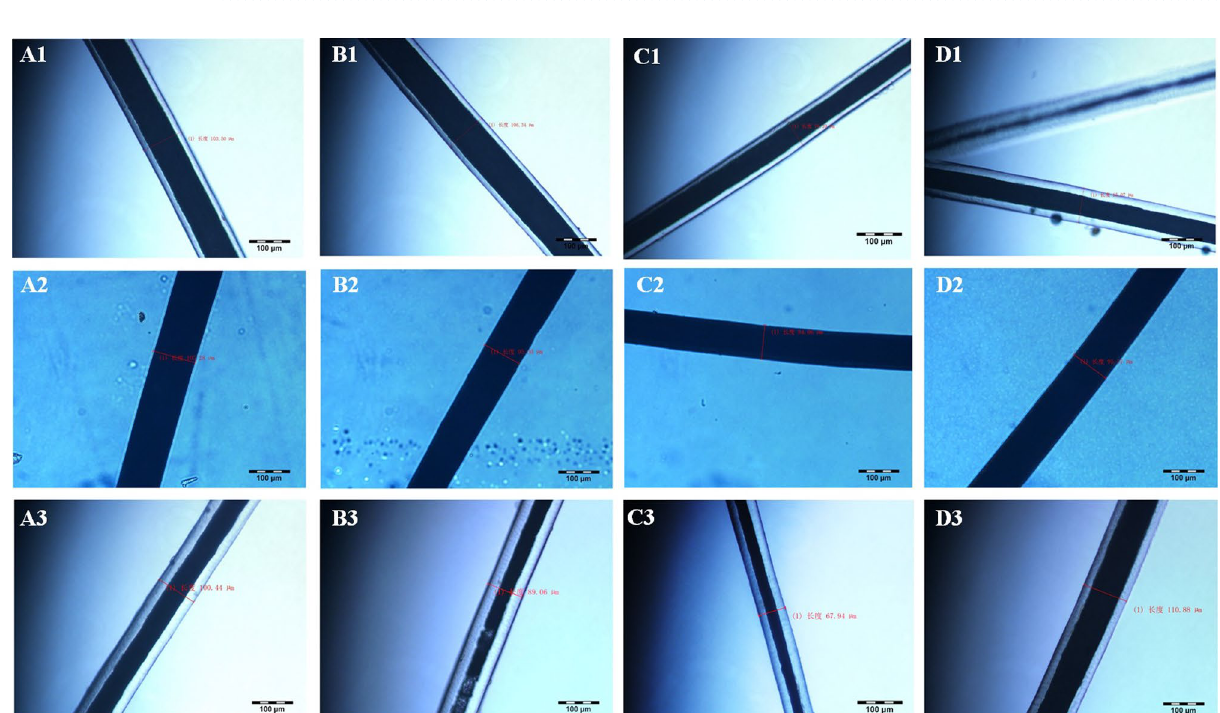
Figure 2. The diameter of hair of ( 1 ) Inner Mongolia cashmere goat (IMCG), ( 2 ) Dazu black goat (DBG) and ( 3 ) IMCG x DBG (F 1 ) for ( A ) shoulder, ( B ) side-portion, ( C ) abdomen and ( D ) leg